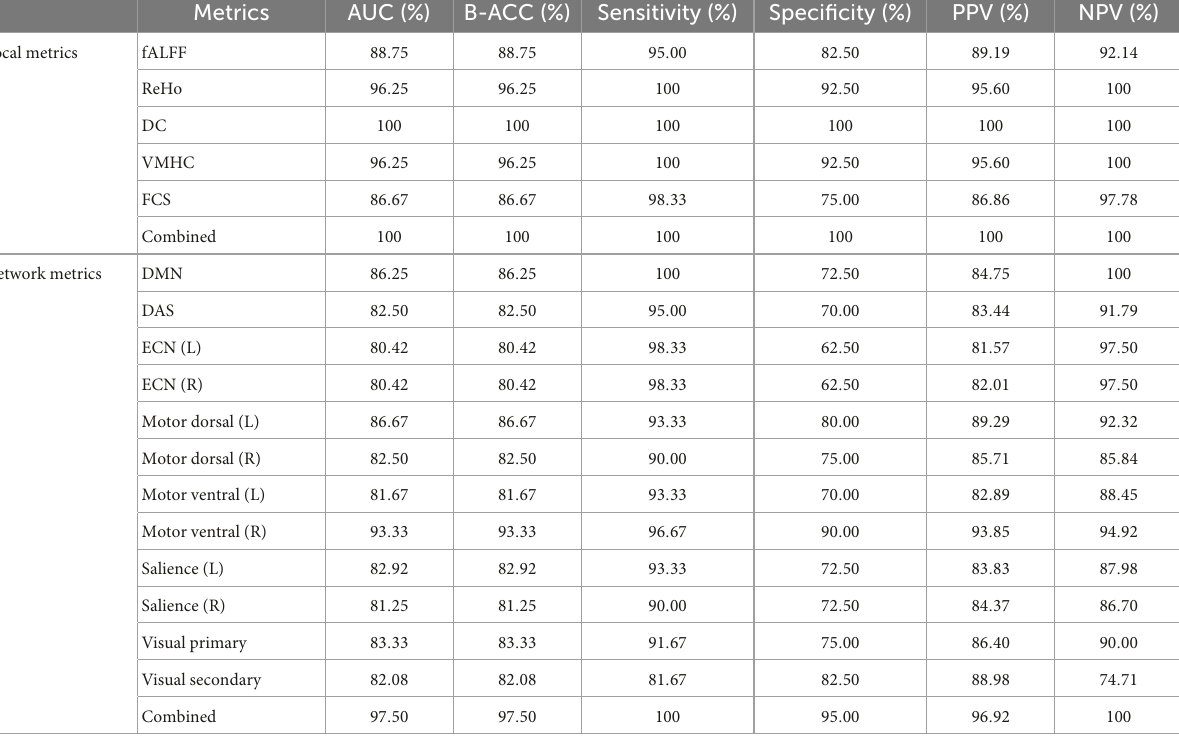
TABLE 5 Classification performances of single metric model and combined model for local and network rs-fMRI metrics. Metrics AUC (%) B-ACC (%) Sensitivity (%) Specificity (%) PPV (%) NPV (%) Local